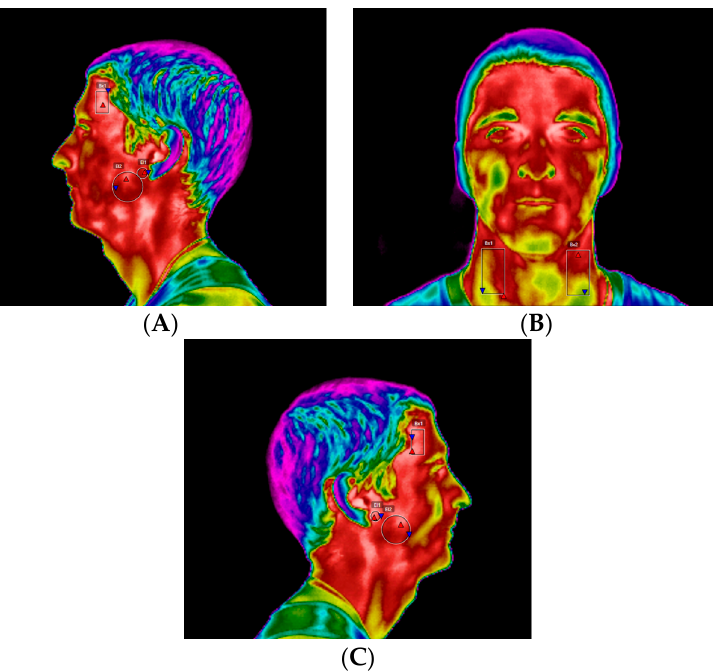
Figure 11. Regions of interest of the thermographic analysis: Anterior neck triangle, temporomandibular joint (TMJ), superficial masseter and anterior temporal muscles. ( A ) Left profile; ( B ) Front view; ( C ) Right profile.